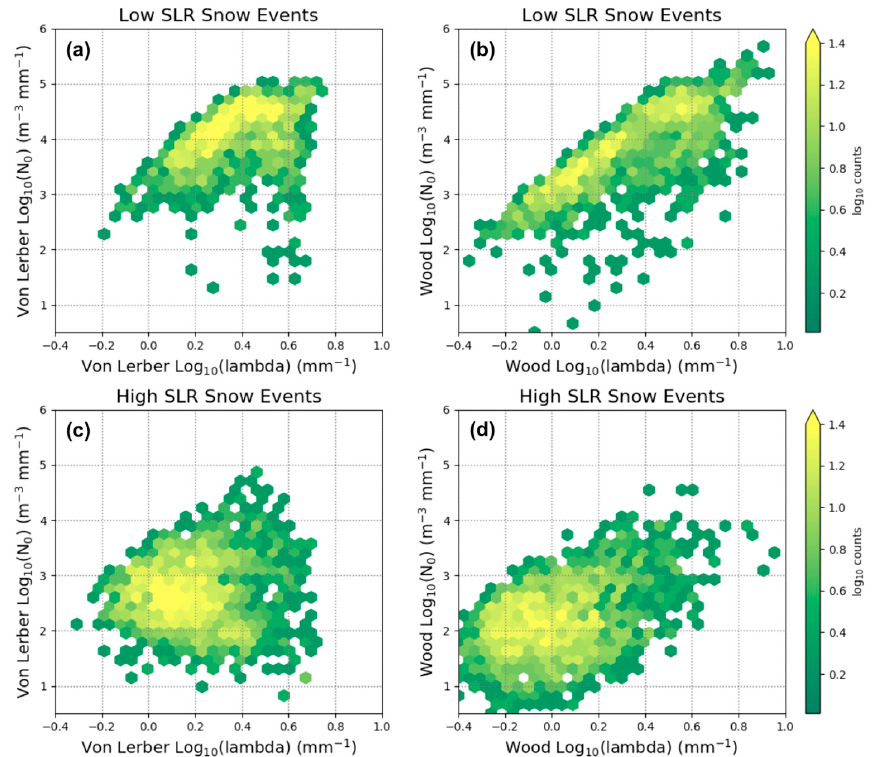
Figure 3. The N 0 and Λ relationships as calculated for the low SLR snow events are shown in ( a ) (von Lerber) and ( b ) (Wood). The N 0 and Λ relationships as calculated for the high SLR snow events are shown in ( c ) (von Lerber) and ( d ) (Wood). Note that both variables are shown as log 10 scaled.